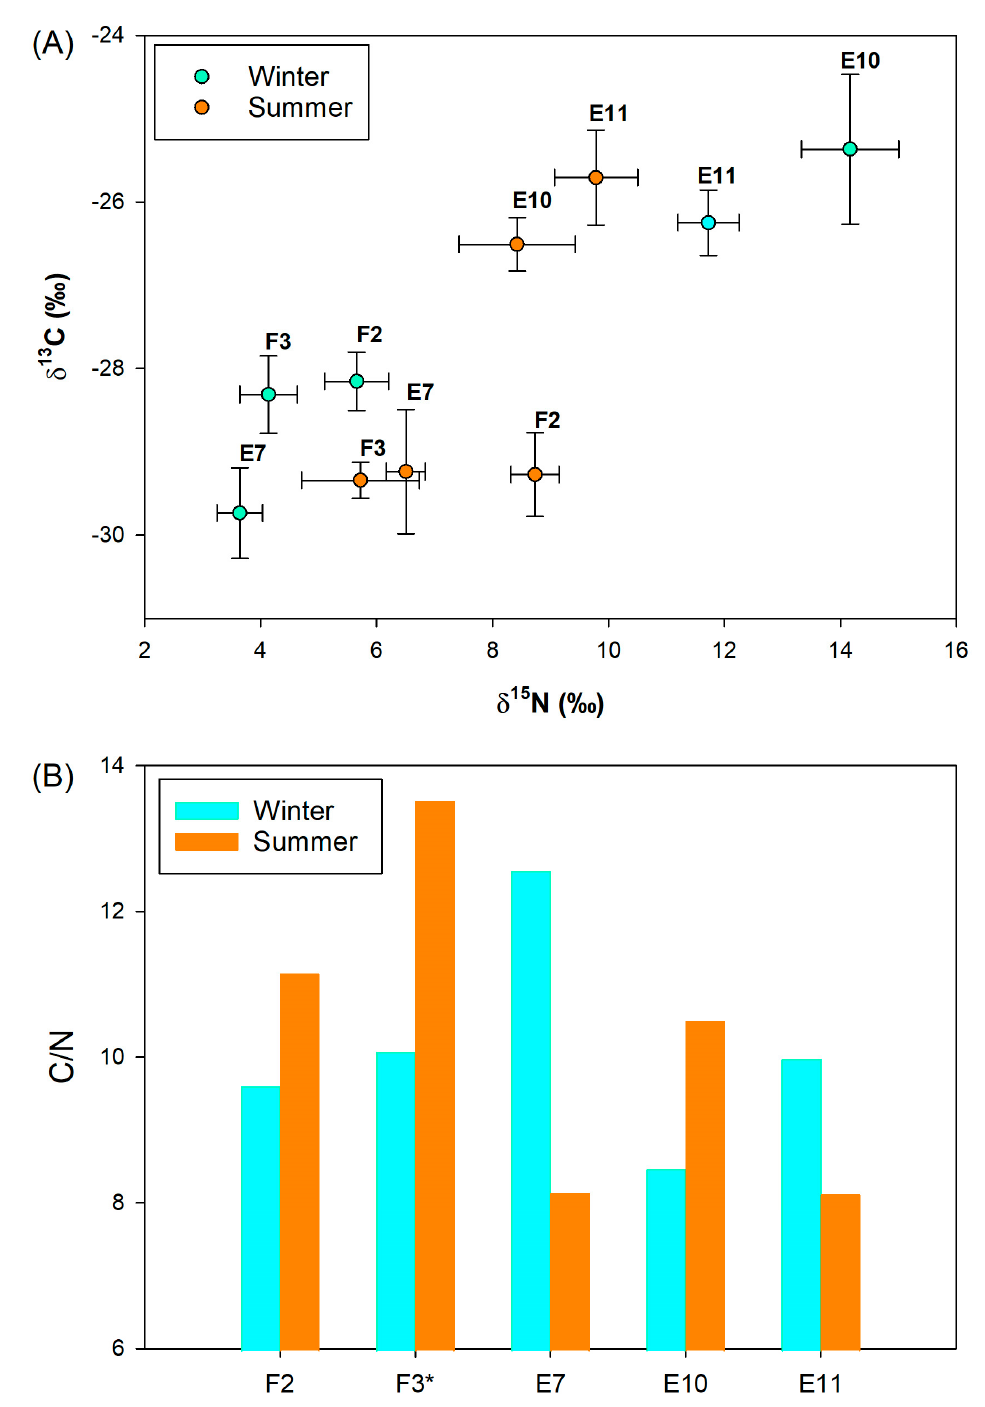
Figure 5. Isotopic organic matter signatures ( A ) and C/N rates ( B ) in sediments during winter and summer of El Sauce estuary. * Discharge Station.